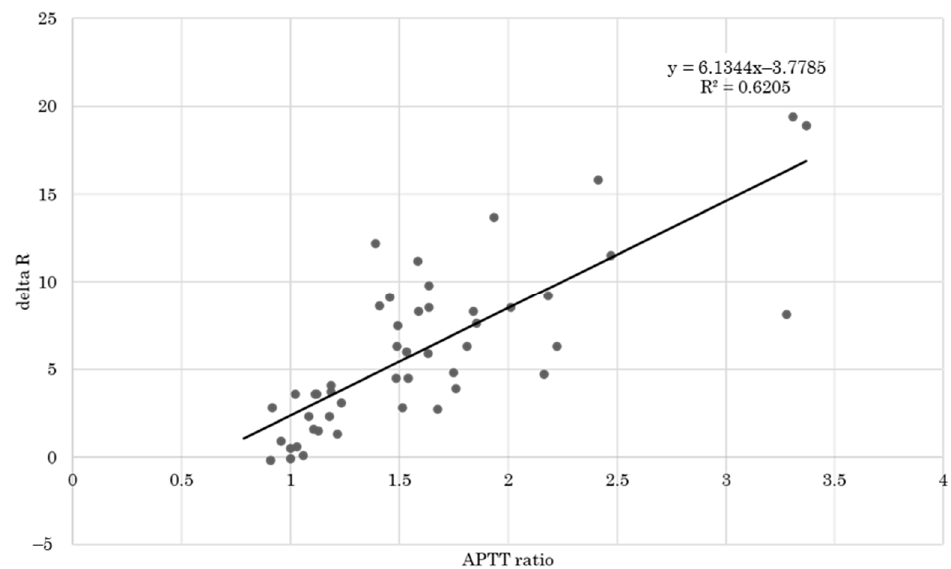
Figure 5. Correlation analysis between delta R (difference between R of CK and R of CKH) and the activated partial thromboplastin time (APTT) ratio. CK = citrated kaolin, CKH = citrated kaolin with heparinase.